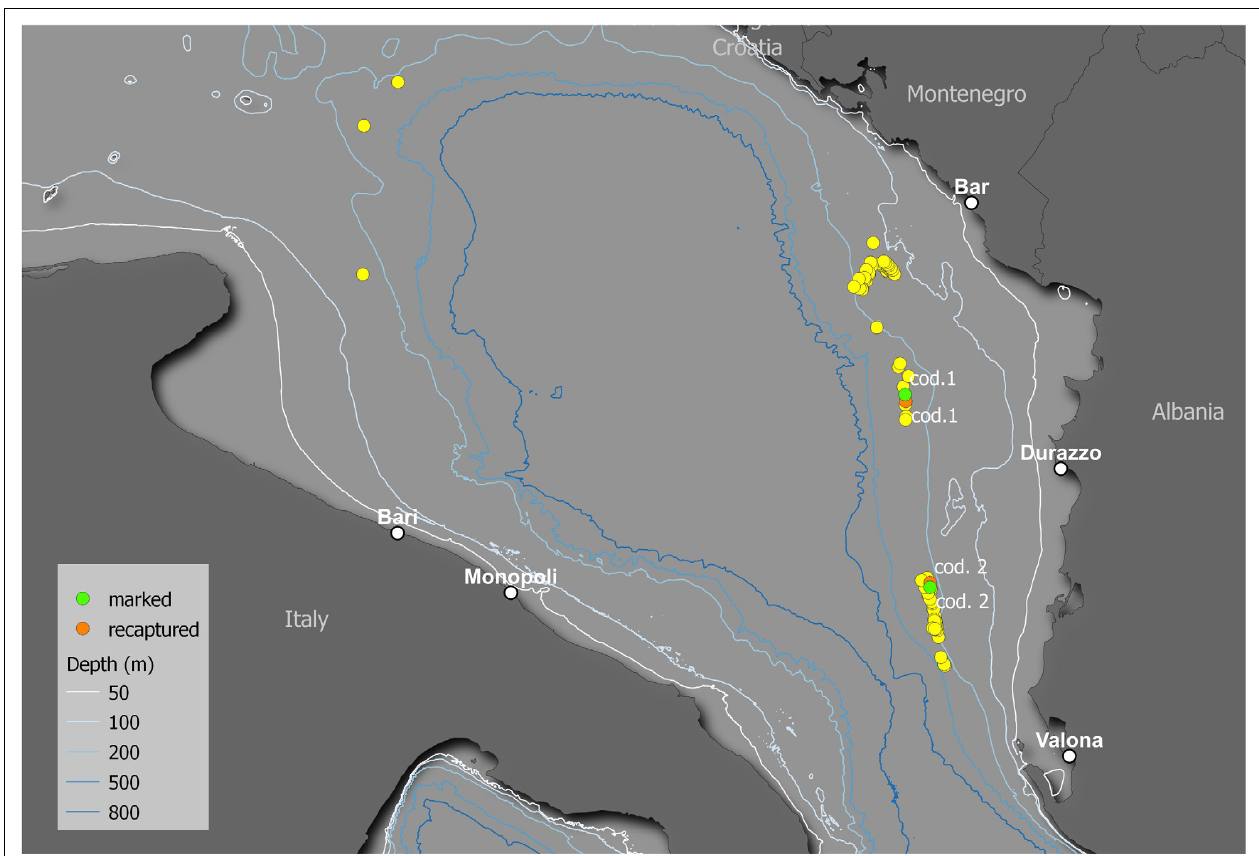
FIGURE 9 | Map of the release locations of the captured specimens. The yellow points indicate the release locations of the specimens that were not recaptured. The green and orange points indicate the release and recapture locations, respectively, of the two recaptured specimens (cod. 1 and cod. 2).